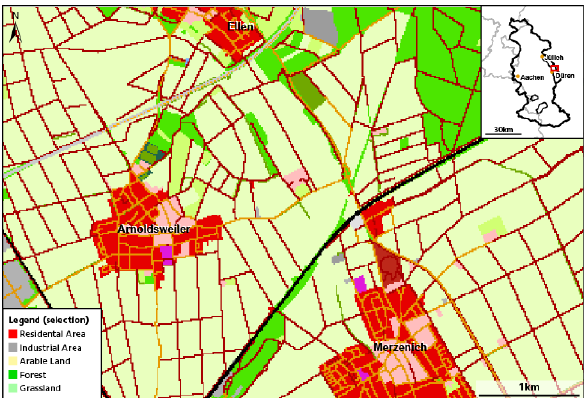
Figure 2. Rasterised subset of the ATKIS Basic-DLM for Germany (data source: Geobasis